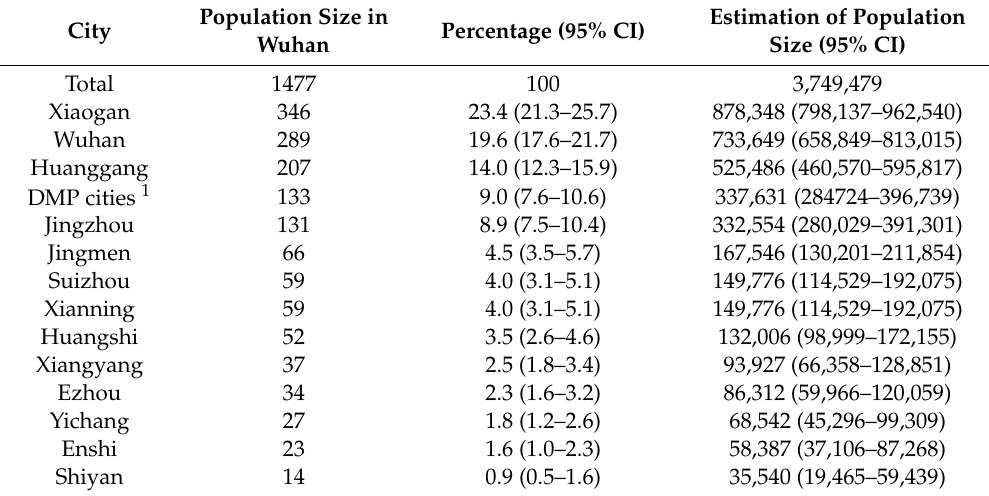
Table 6. Estimation of proportion and population size in Hubei Province based on floating population in Wuhan, 2017.